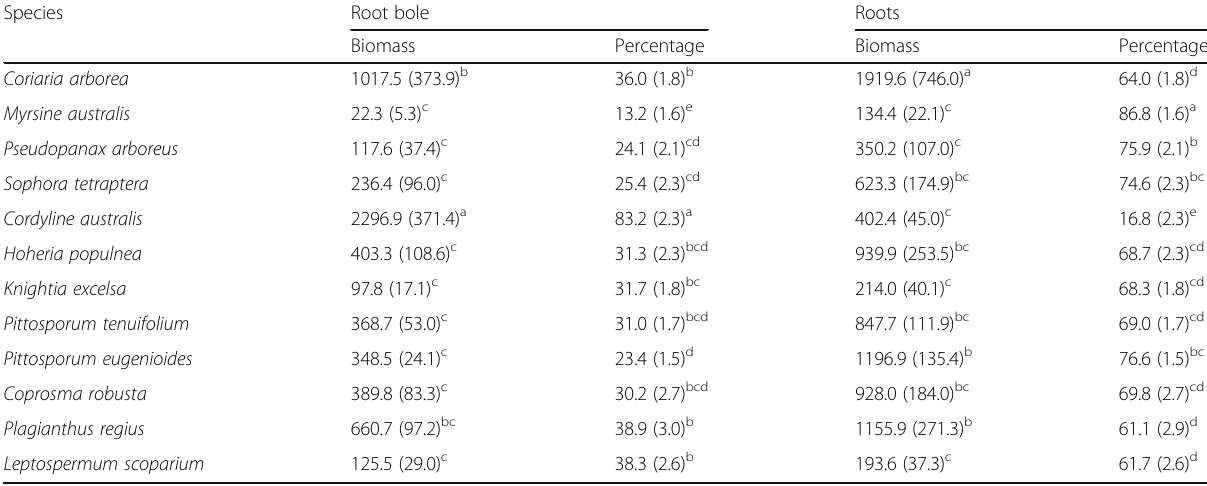
Table 2 Mean root bole and root biomass (g) and as a percentage of total below-ground biomass by year 5